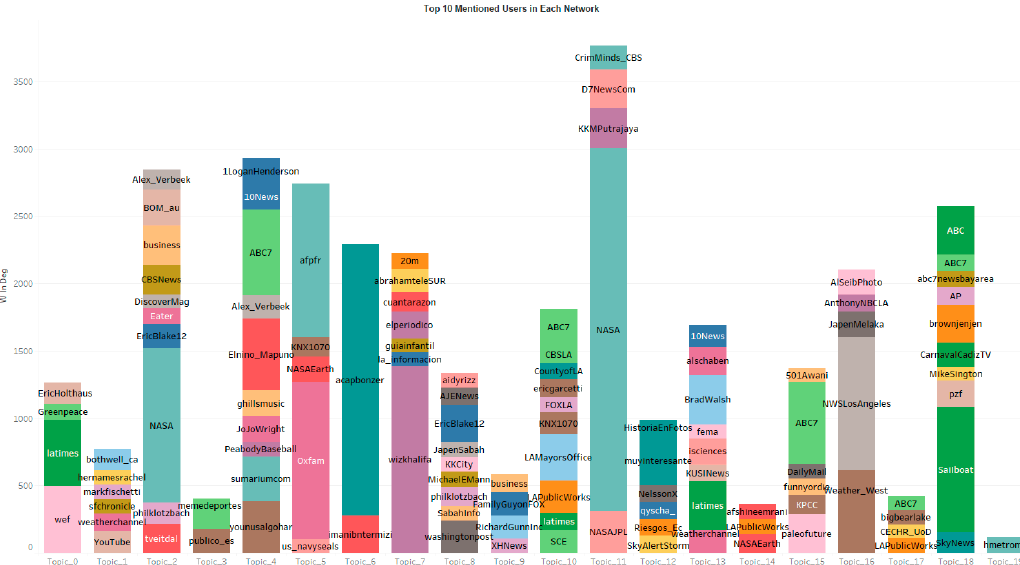
Figure 7. The top 10 mentioned users.